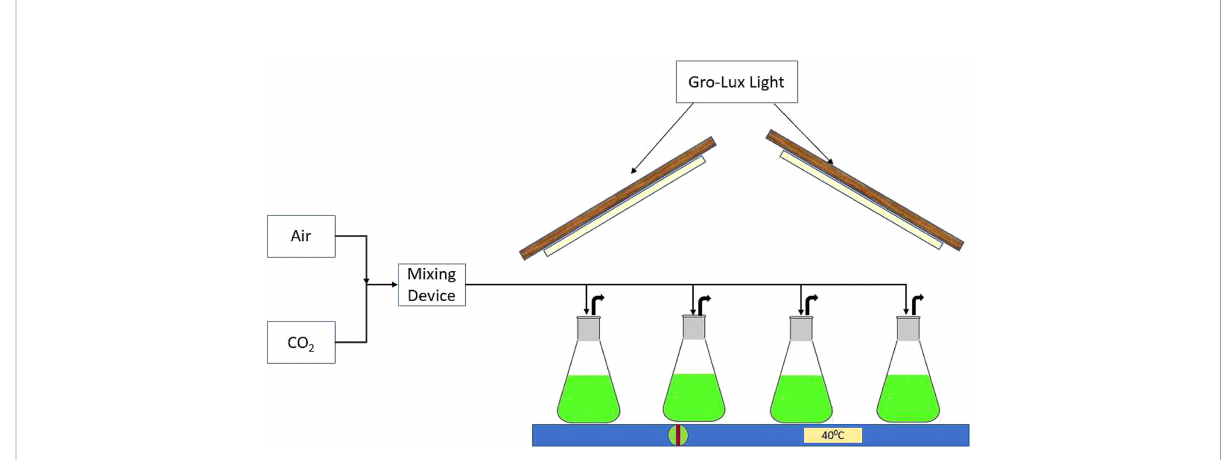
FIGURE 8 Process diagram of microalgae cultivation environment. (reproduced with permission from Hossain et al.,